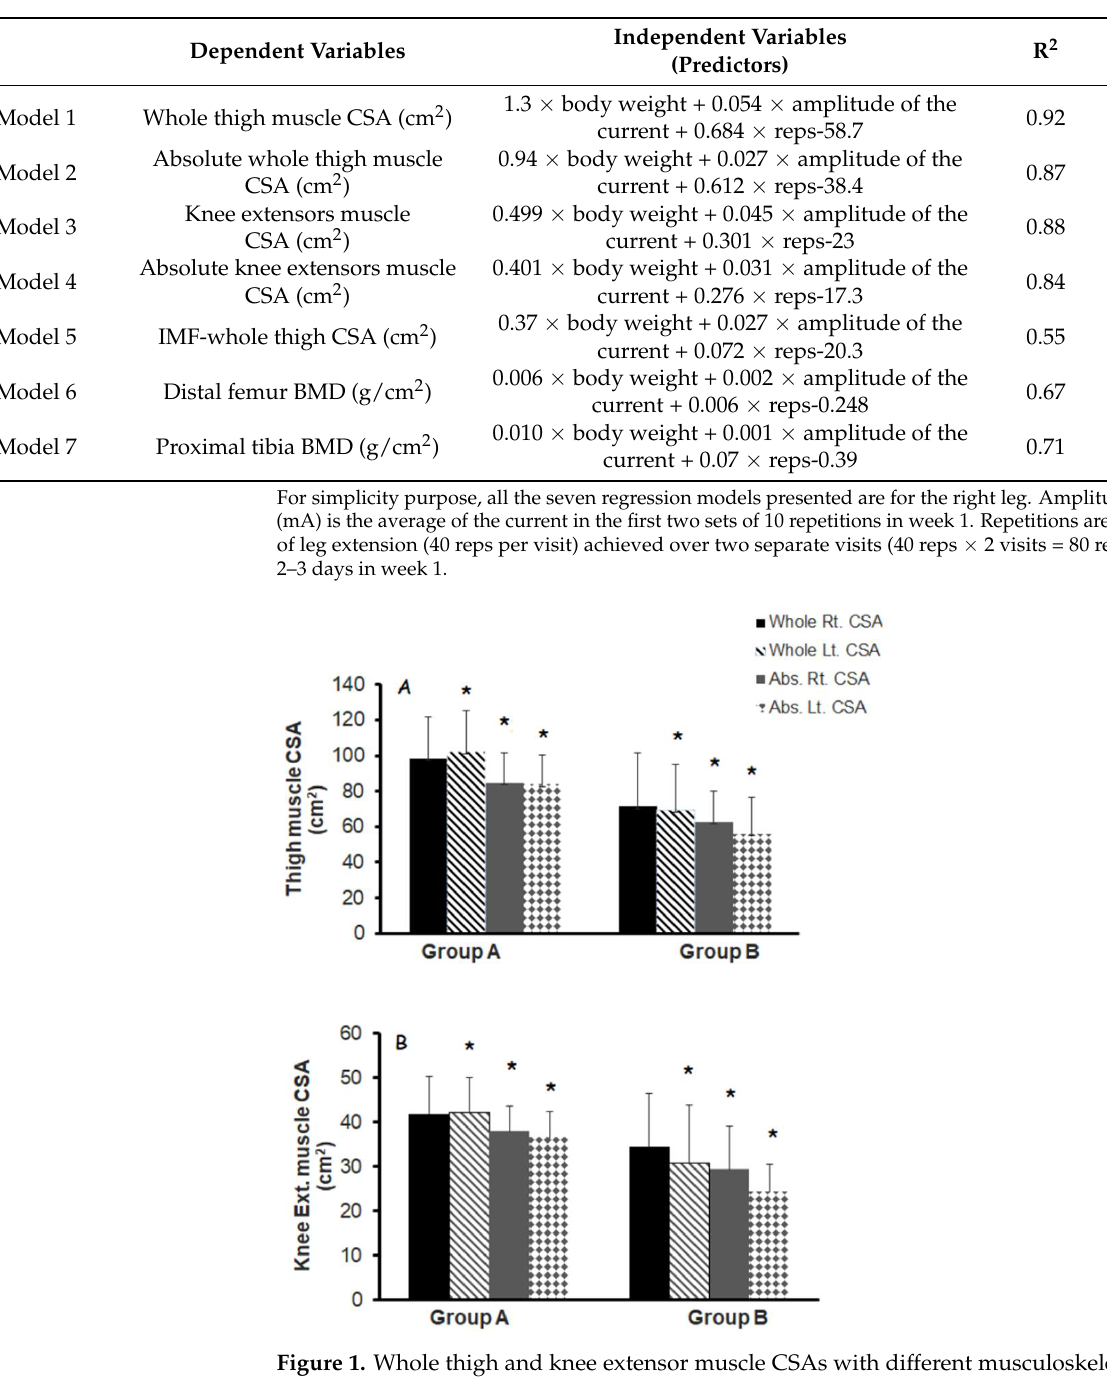
Table 3. Regression analysis models using body weight, amplitude of the current (mA) and repetitions as independent variables to predict muscle CSA, IMF CSA and BMDin persons with SCI.